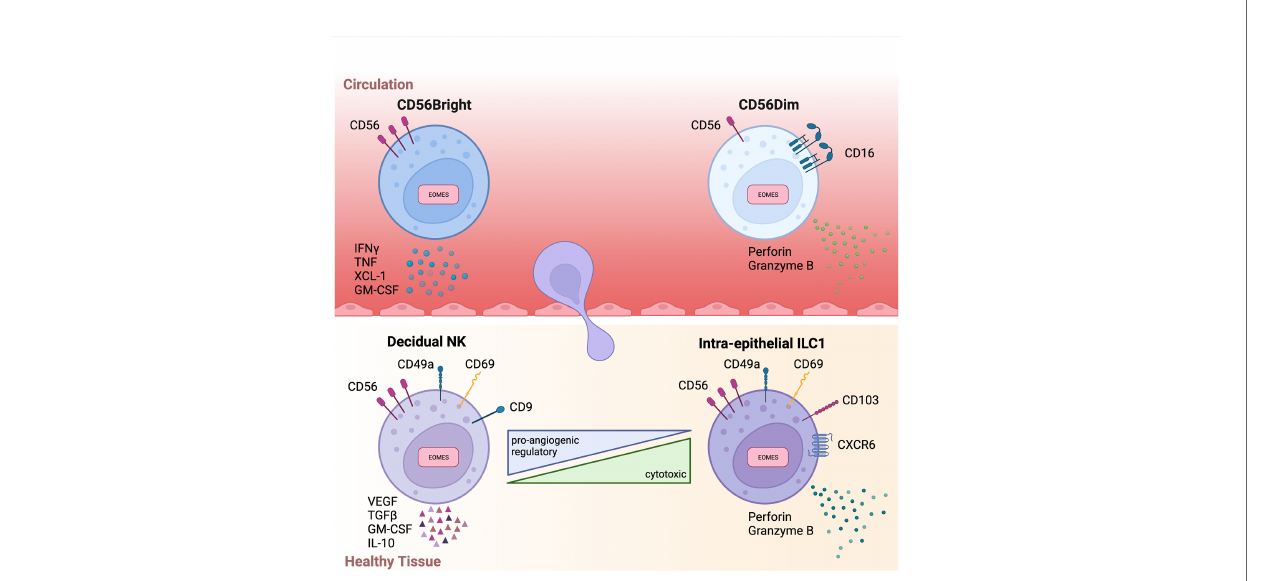
FIGURE 1 | Overview of circulatory and tissue-resident NK phenotypes .Schematic summary highlighting key phenotype markers and functions of circulatory (above) and tissue-resident (below) NK cells. Interferon gamma (IFN g ), Tumor necrosis factor (TNF), Transforming growth factor beta (TGF b ), Granulocyte- macrophage colony-stimulating factor (GM-CSF), Vascular endothelial growth factor